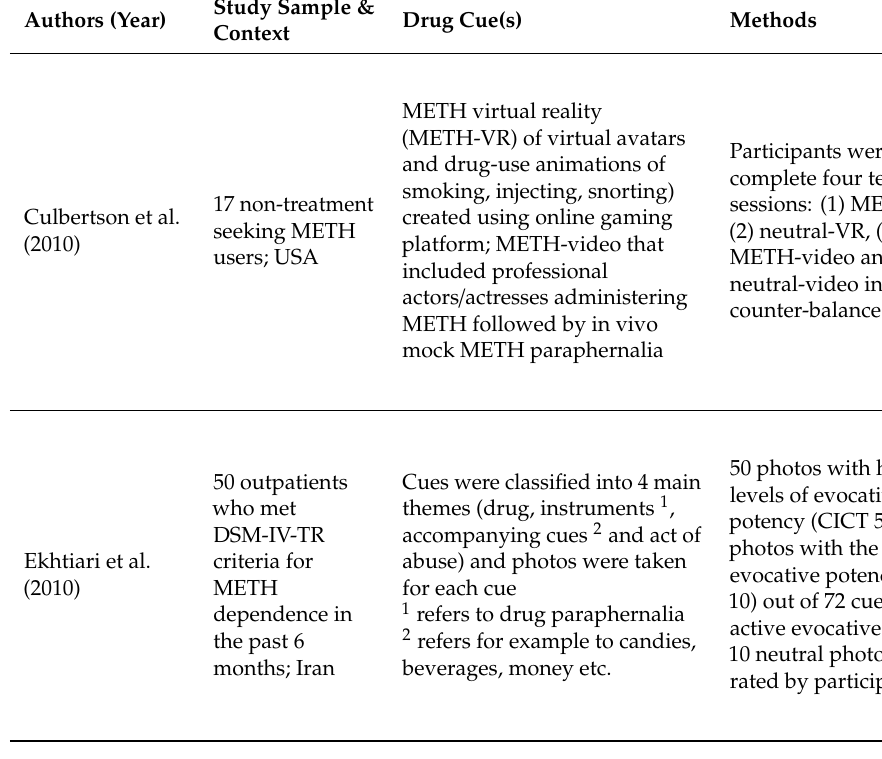
Table 1. Details of included studies that looked at the e ff ects of drug cue exposure and factors associated with change in cravings upon cue exposure. Authors